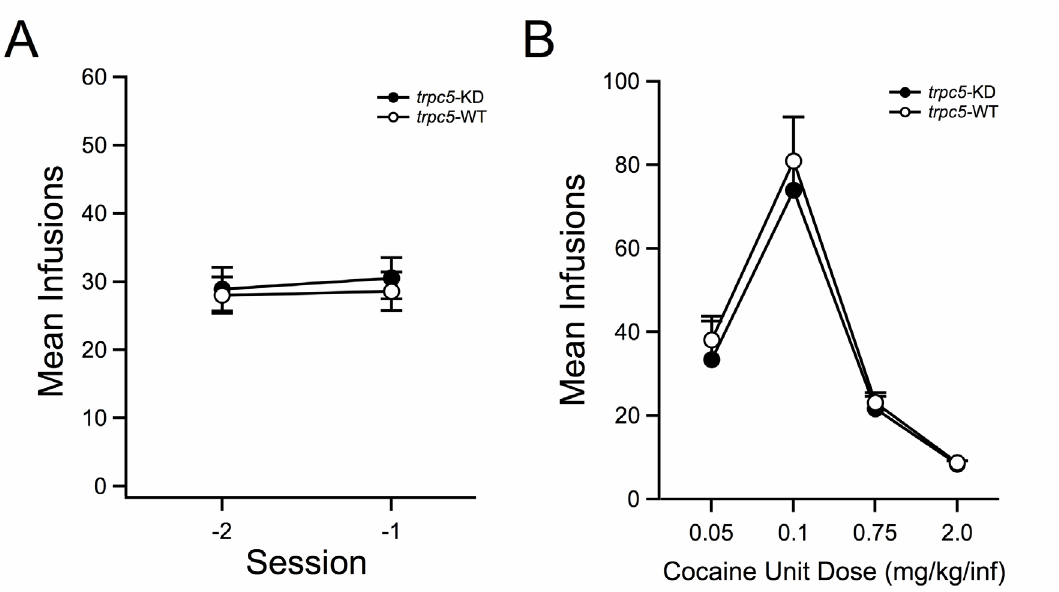
Figure 2. A. Mean (± SEM) number of infusions for the last two self-administration sessions prior to the dose-response challenge are similar between trpc5 -KD and WT mice. Cocaine- trpc5- KD ( n = 9) versus Cocaine- trpc5- WT ( n = 10). B. Mean (± SEM) number of infusions for 2 sessions at each indicated cocaine dose. Dose-response curves reveal similar responding to varying unit doses of cocaine between